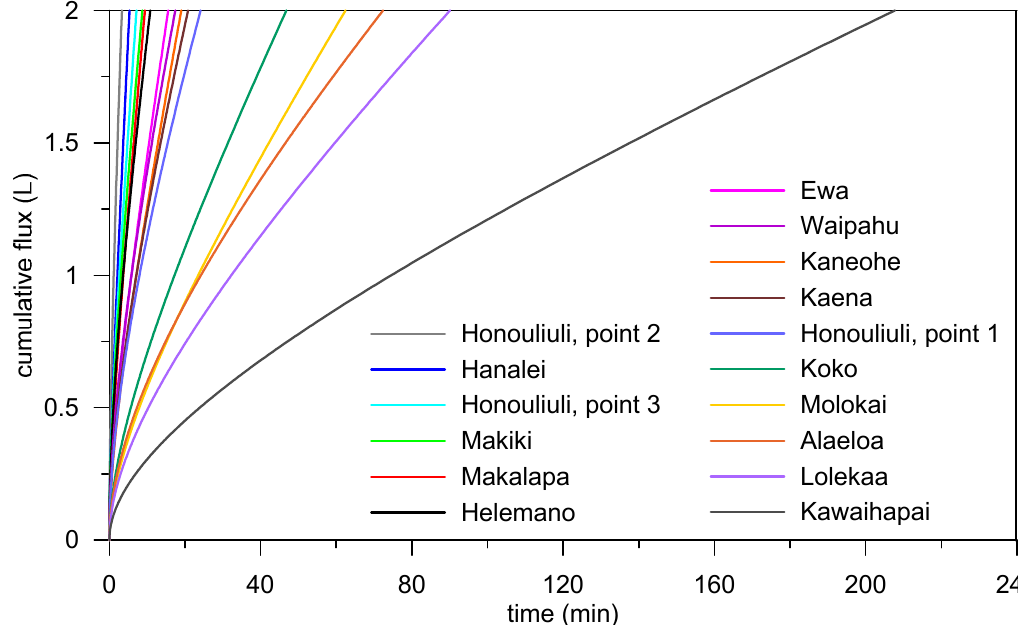
Figure 7. Cumulative flux through from a hypothetical infiltration trench for sixteen simulated soils.